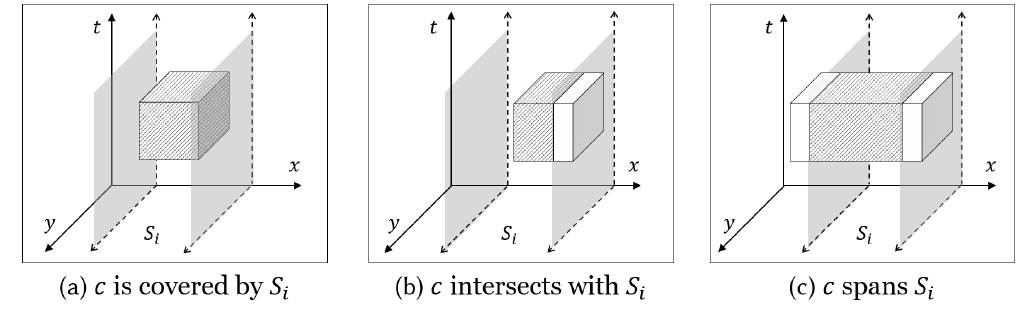
Figure 9. Cases when subspace S i overlaps with c